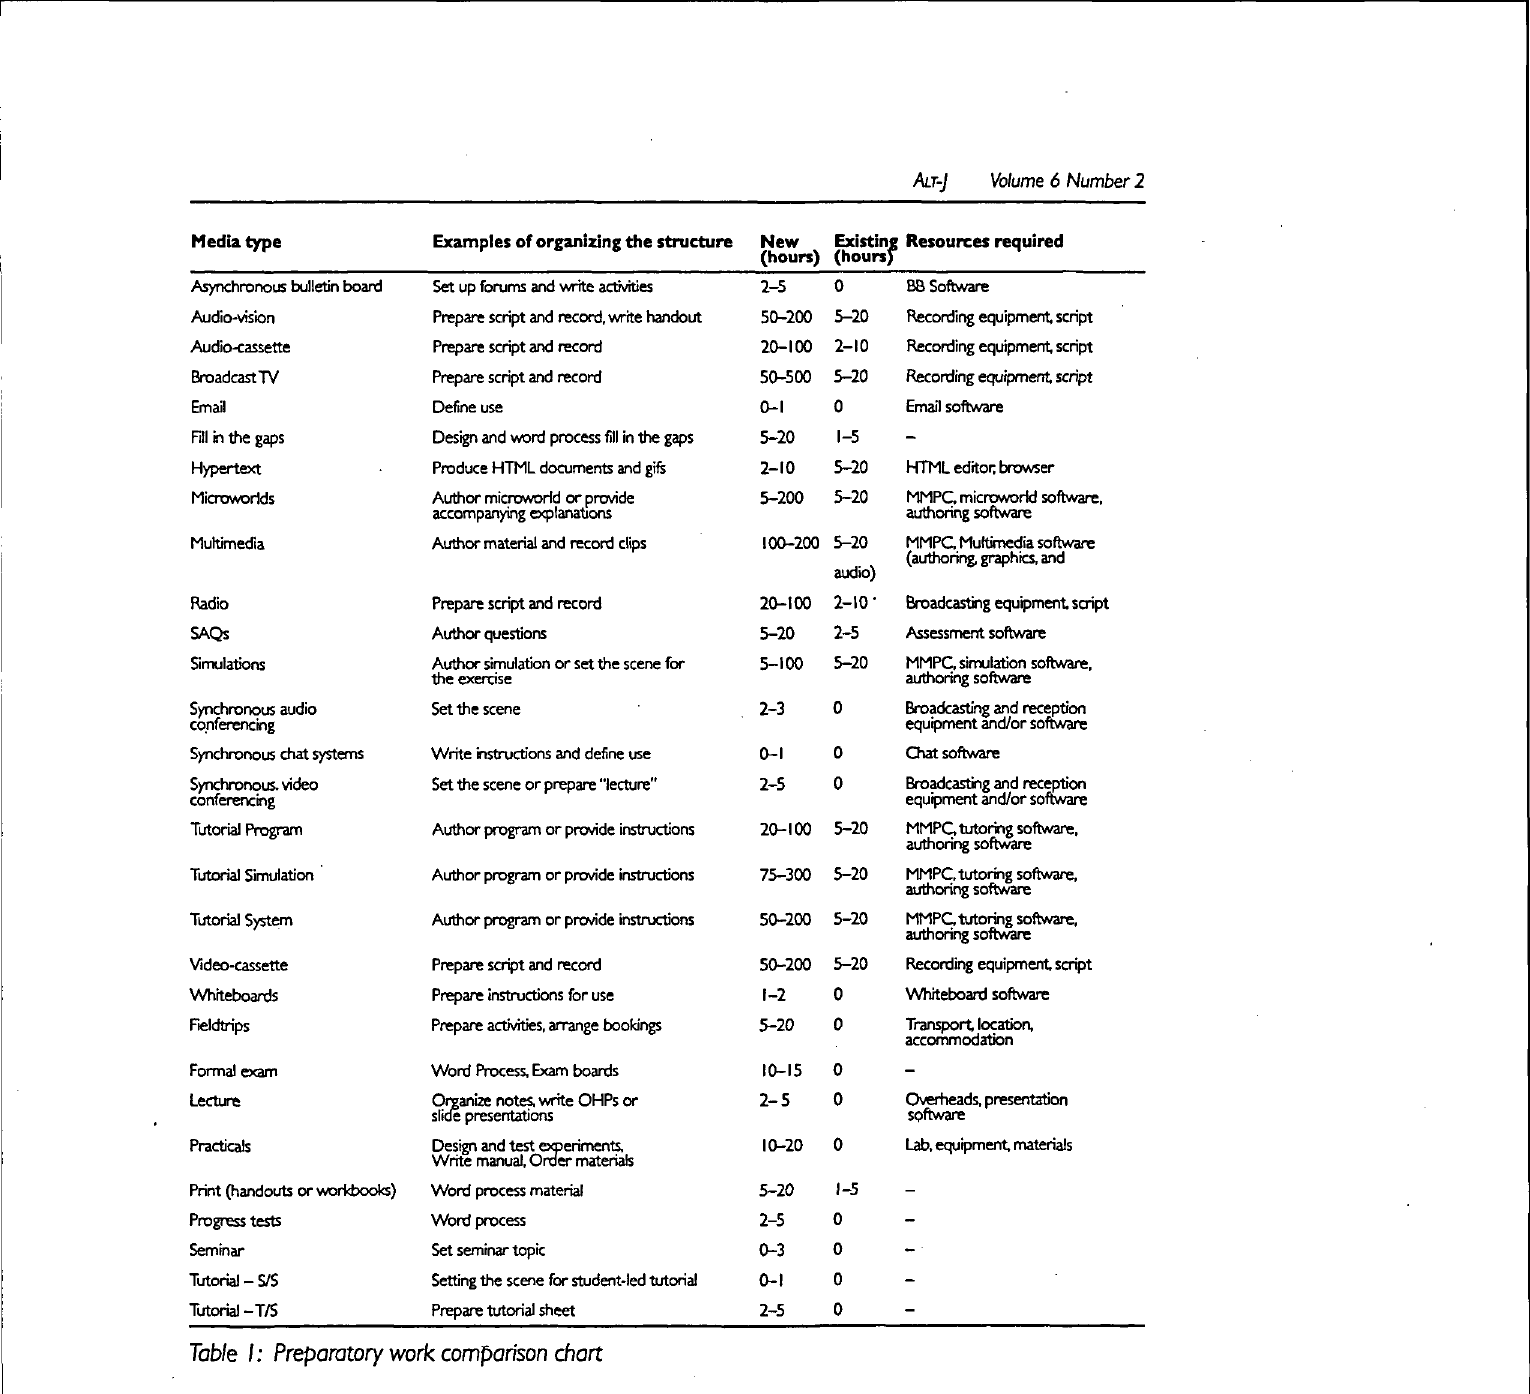
Table I: Preparatory work comparison chart grading. This grading rates media uses from 0 (rarely if ever supports this interaction) to 3 (this interaction is central). This provides a much finer analysis of the strengths and weaknesses of resources, providing a clearer picture of the educational benefits of different media